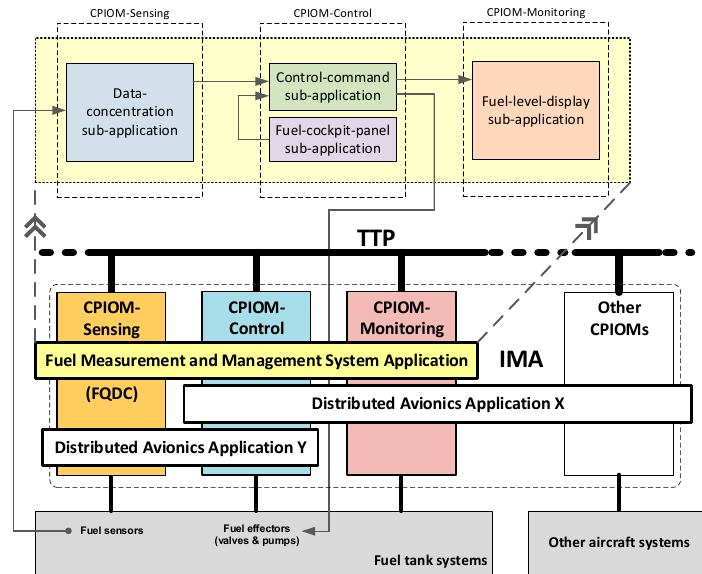
Figure 6. Distributed fuel control